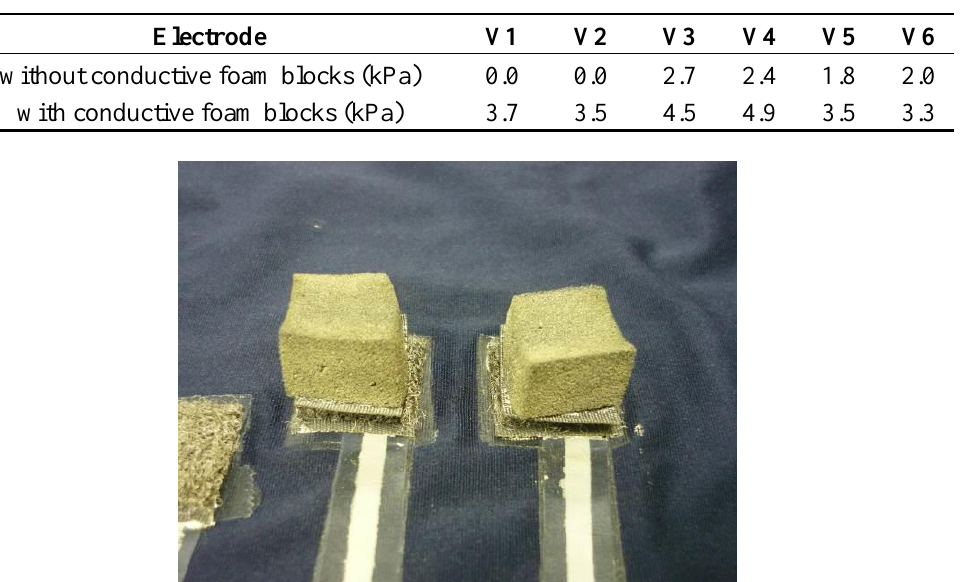
Table 1. Compression pressures at electrodes V1 to V6.